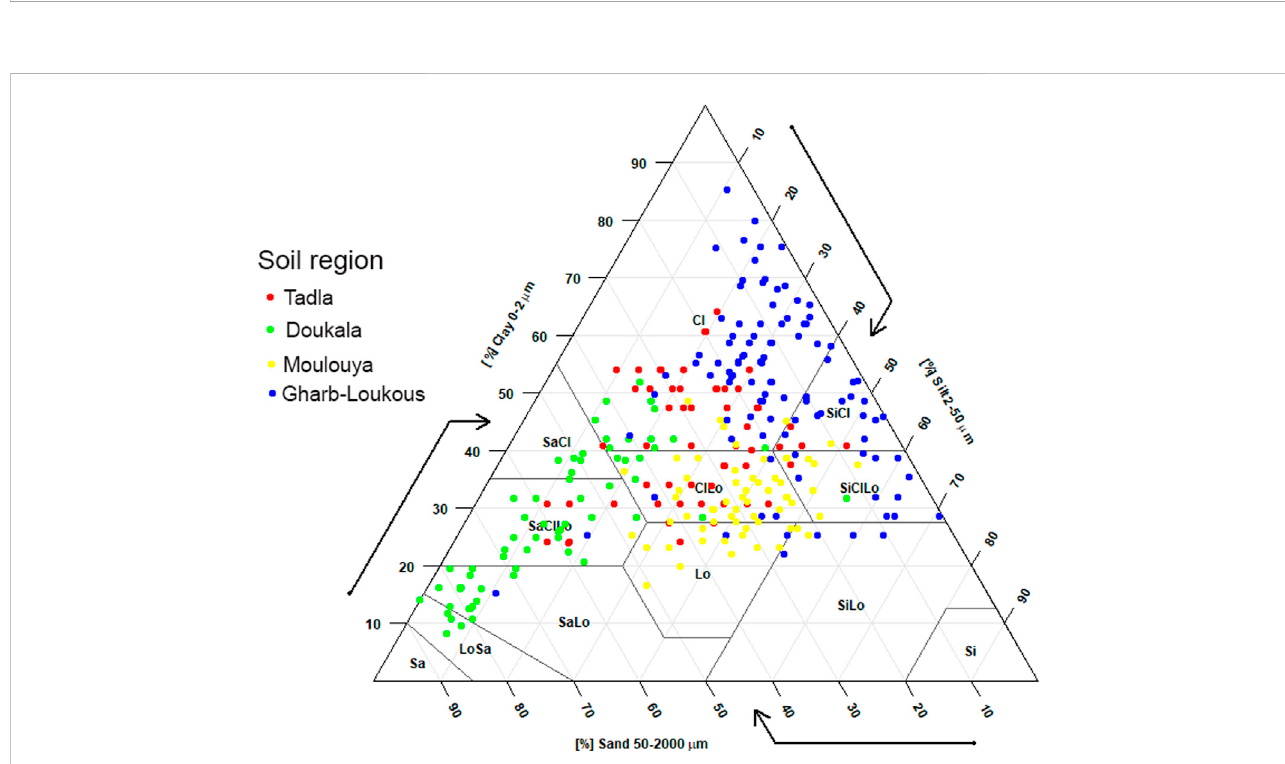
FIGURE 3 Soil texture of the collected samples plotted by soil region based on USDA texture classi fi